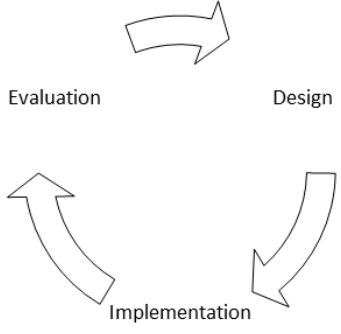
Figure 3. Human-computer interaction (HCI) as a usability engineering process.